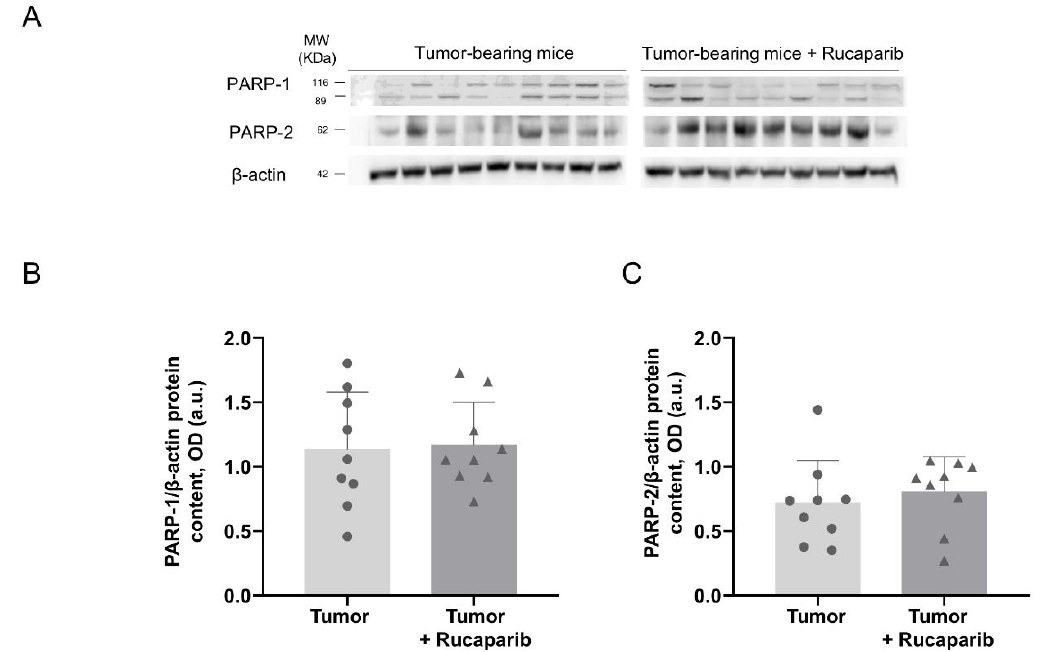
Figure 2. Representative immunoblots of PARP-1, PARP-2 and β -actin proteins in the tumors of both study groups ( A ). Mean values and standard deviations of PARP-1 ( B ) and PARP-2 ( C ) protein content. In the scatter plot, the circles represent the untreated tumor-bearing mice while the triangles represent the rucaparib treated tumor-bearing mice. Definition of abbreviations: PARP, poly-ADP ribose polymerase; OD, optical densities; a.u., arbitrary units.